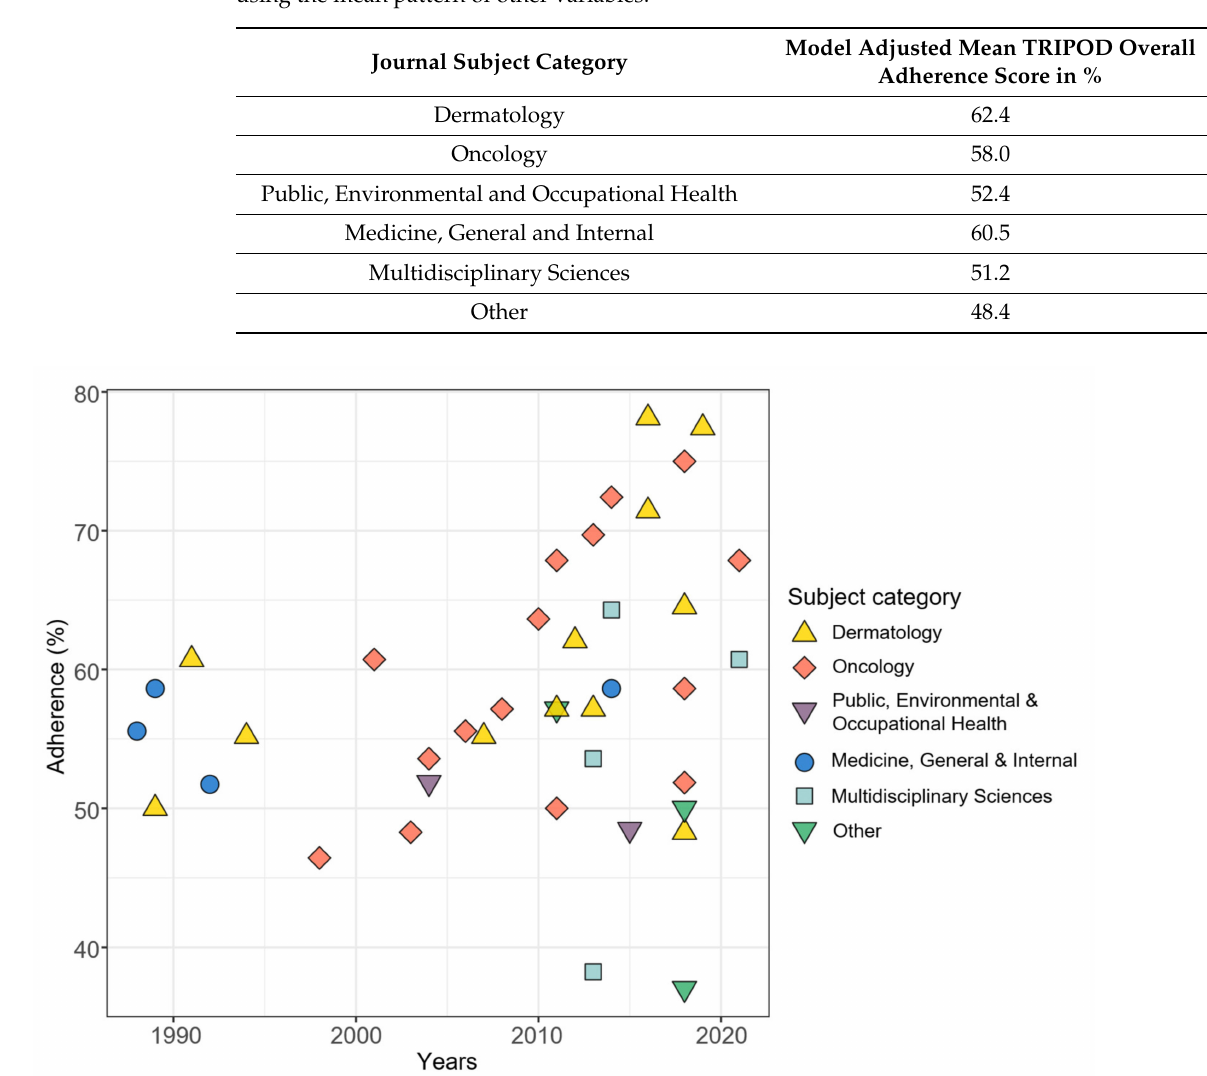
Table 3. Model adjusted mean TRIPOD overall adherence scores for each journal subject category using the mean pattern of other variables.